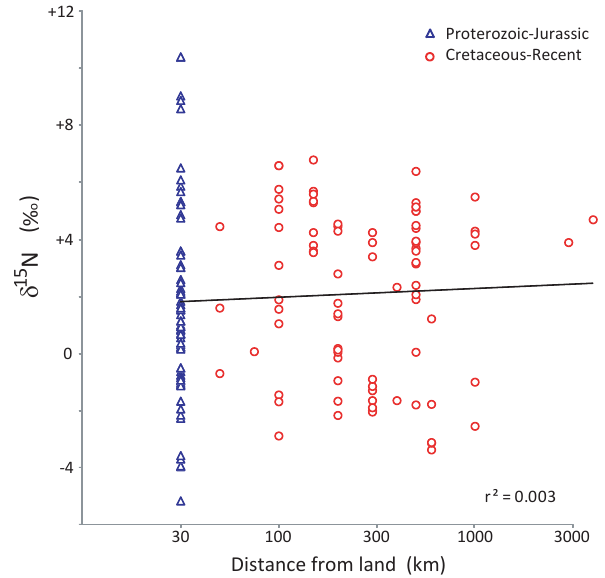
Figure 2 Fig. 2. Mean δ 15 N sed versus distance from land. All Proterozoic to Jurassic units were arbitrarily plotted at a distance of 30 km owing to their epicontinental settings and uncertainties regarding paleocoastal geography. Distances for Cretaceous to Recent units were measured from the paleogeographic map series of Ron Blakey (Colorado Plateau Geosystems, http://cpgeosystems.com/). Note the lack of any relationship between δ 15 N and the distance of the depositional site from